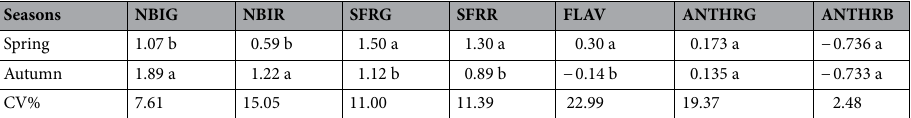
Table 3. Average values of nitrogen balance (NBIG and NBIR), chlorophyll (SFRG and SFRR), flavonoids (FLAV) and anthocyanins (ANTHRG and ANTHRB) indexes of purple lettuce grown at different seasons. Means followed by the same letter do not differ from each other at the 5% probability level (p < 0.05) by the Tukey test.